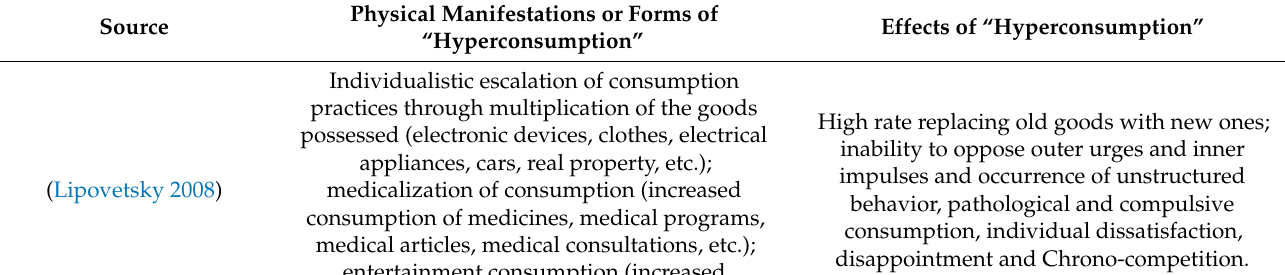
Table 1. Physical manifestations and effects of